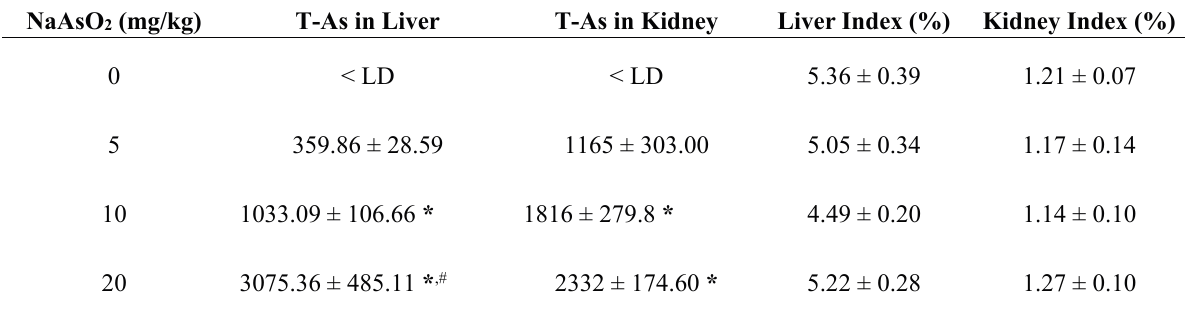
Table 1. Total arsenic levels (T-As, ng As/g tissue), as well as the indexes of liver and kidney in control and acute arsenic-exposed